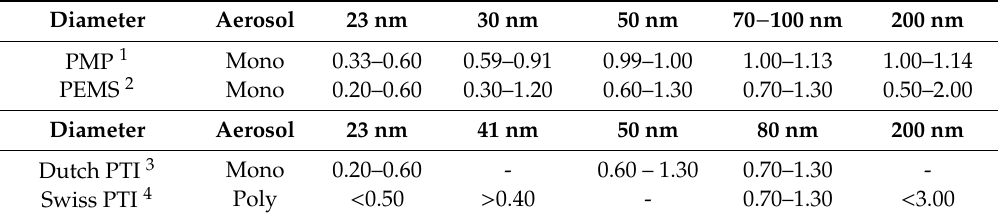
Table 4. E ffi ciency requirements for various systems using monodisperse (mono) or polydisperse (poly)